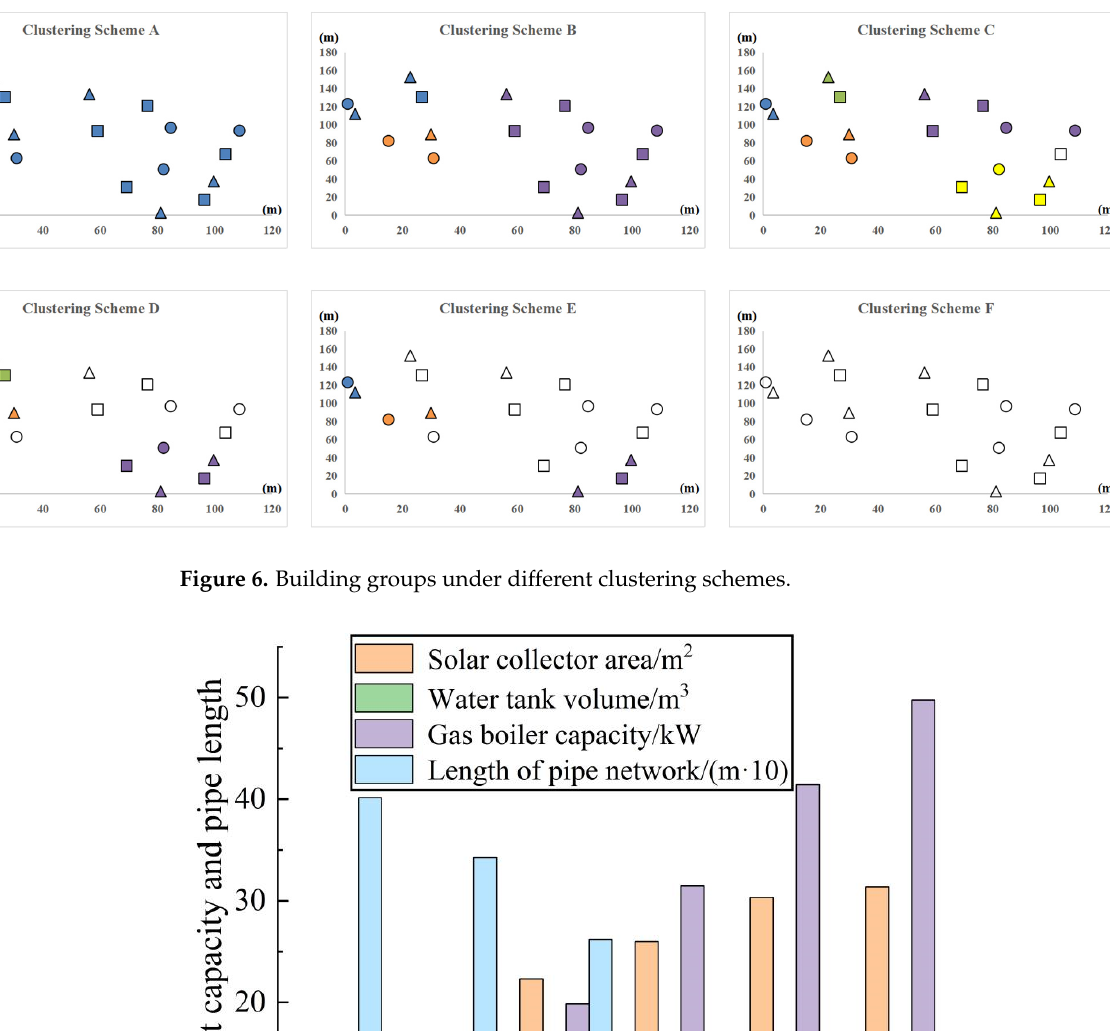
Figure 5. Distribution of buildings with different heating loads in the village.